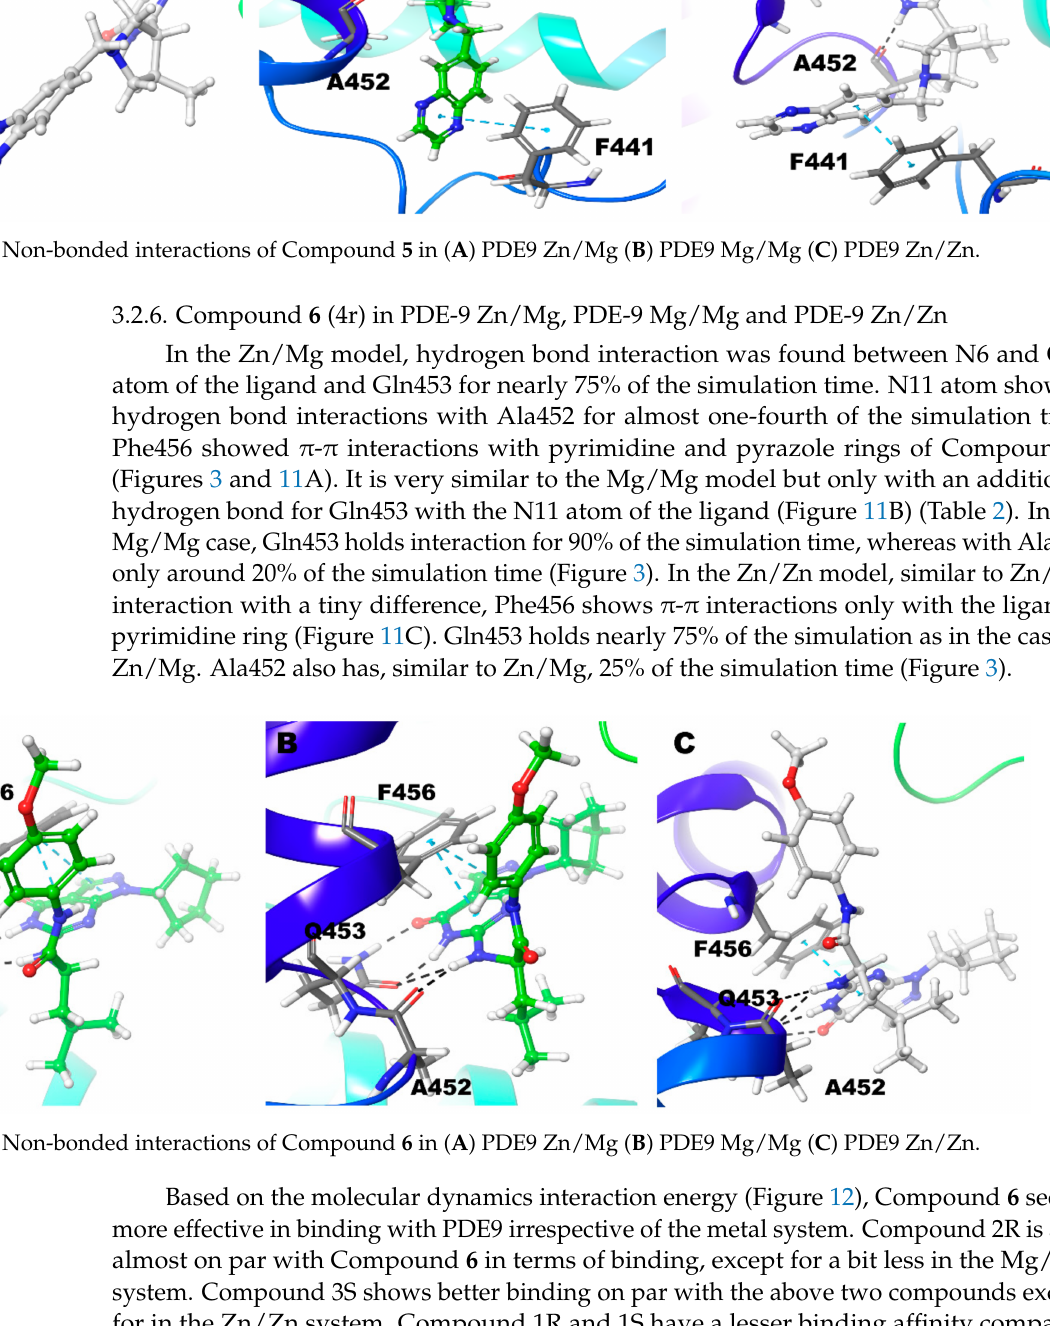
Zn/Zn than Zn/Mg, and in Compound 4 , which is not so favourable with thw Mg/Mg system compared to the other two systems. The RMSD and RMSF plots obtained from the molecular dynamics results were shown in the Supplementary file (Figures